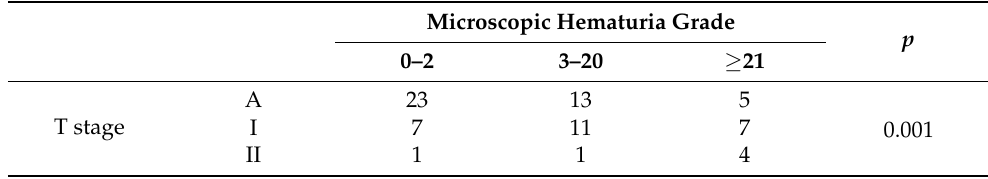
Table 3. Correlation between pathological T stage after transurethral resection of bladder tumor and microscopic hematuria grade.